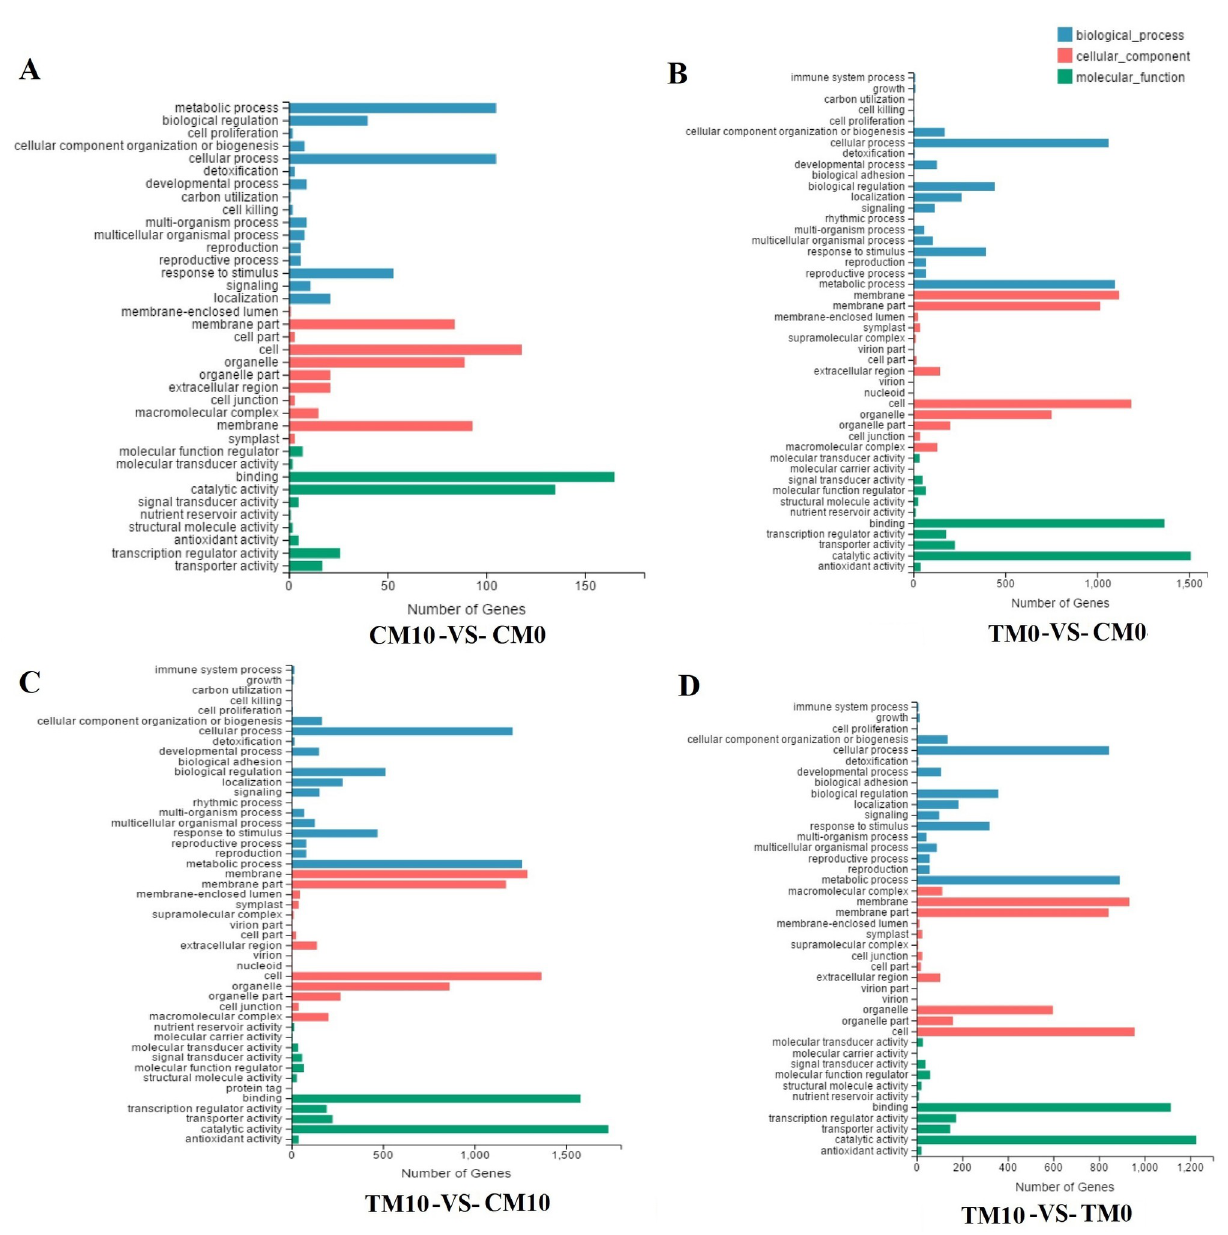
Fig 4. Function annotation of DEGs in the four comparison groups (CM10-vs-CM0, TM0-vs-CM0, TM10-vs-CM10, TM10-vs-TM0) by Gene Ontology (GO) analysis. A. GO analysis of DEGs in the comparison group of CM10-vs-CM0. B. GO analysis of DEGs in the comparison group of TM0-vs-CM0. C. GO analysis of DEGs in the comparison group of TM10-vs-CM10. D. GO analysis of DEGs in the comparison group of TM10-vs-TM0.